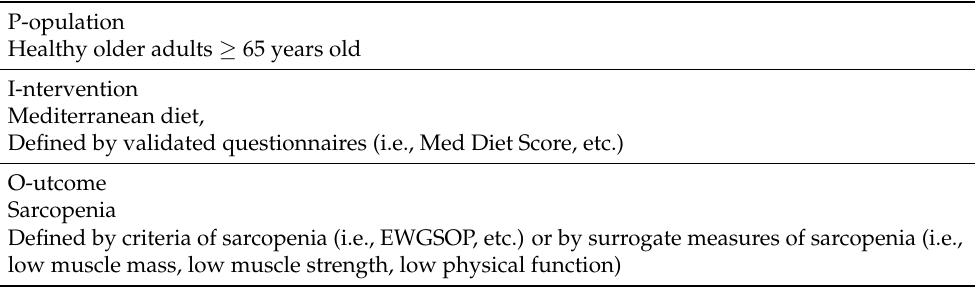
Table 2. Formulation of research question (population, intervention,